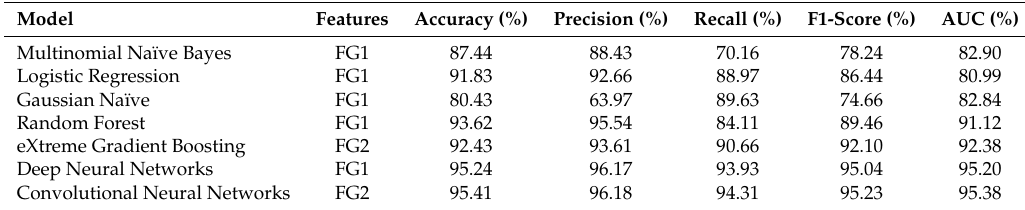
Table 6. The results of the classification models on D3.